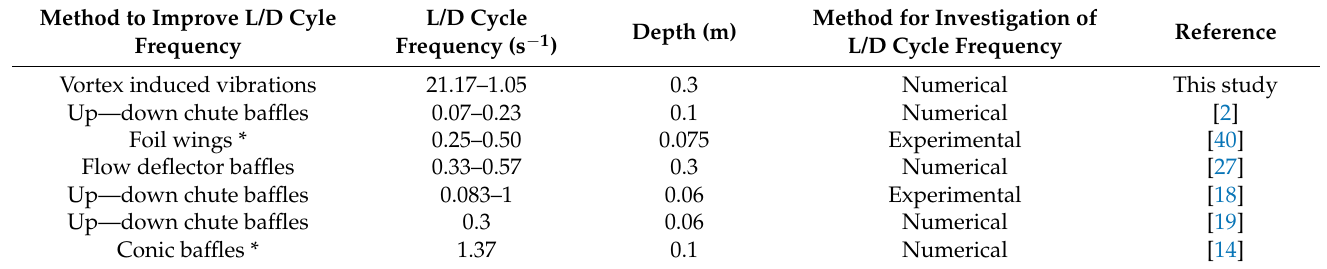
Table 5. Comparison of studies conducted to create L/D cycles to improve biomass productivity in